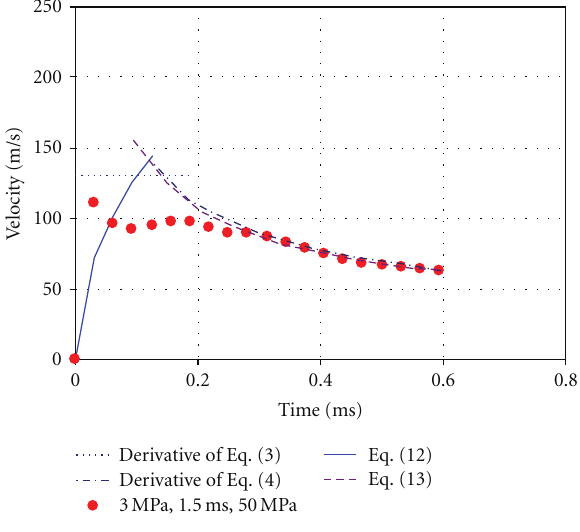
(a) Comparison of old and new models P inj = 50MPa, P amb = 3MPa (b) Comparison of old and new models P inj = 120MPa, P amb = 3MPa